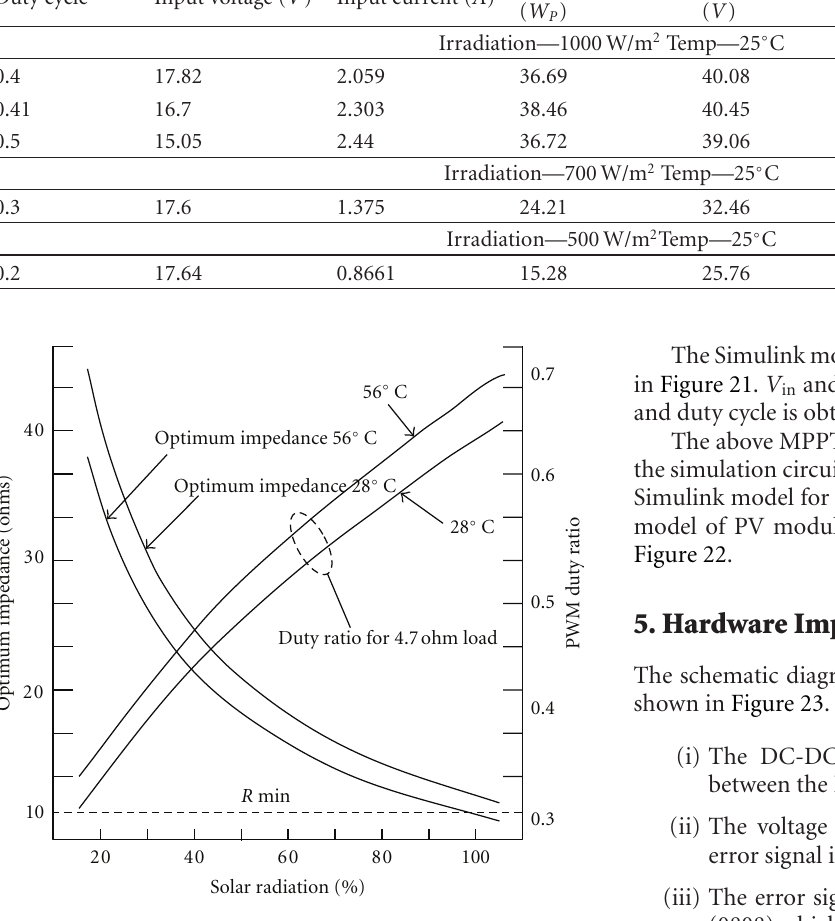
Figure 18: Duty cycle variation with respect to irradiation.